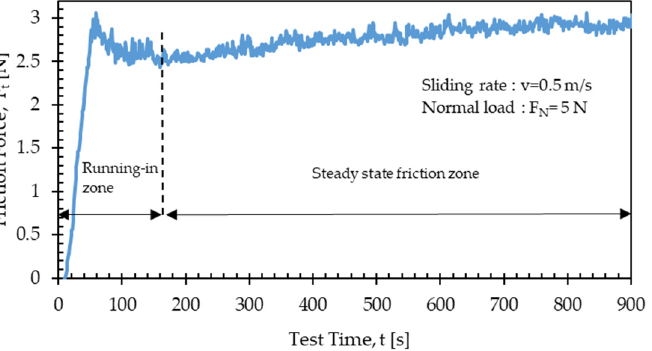
Figure 8. The friction force from the steady-state friction zone for TiAlN coating at 5 N normal load and 0.9 m/s sliding rates.